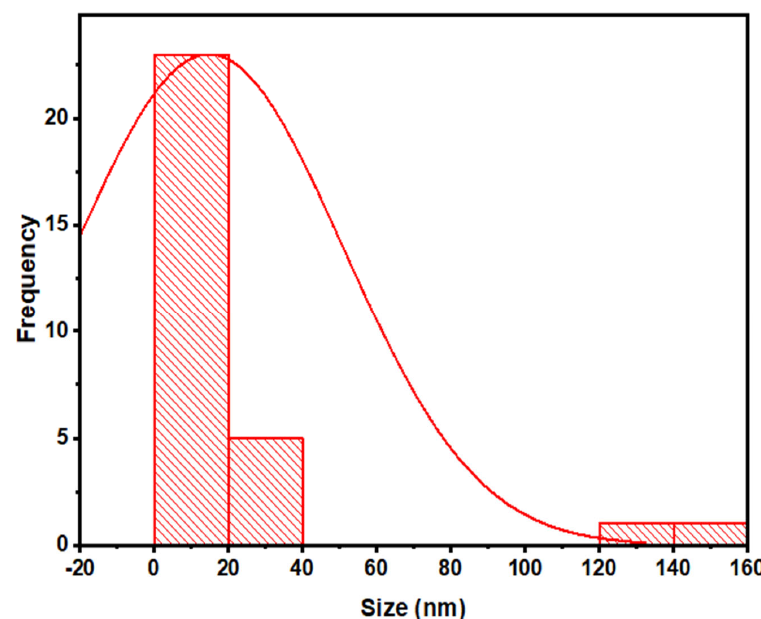
Figure 9. TEM micrograph showing size distribution of mycosynthesized ZnO NPs.